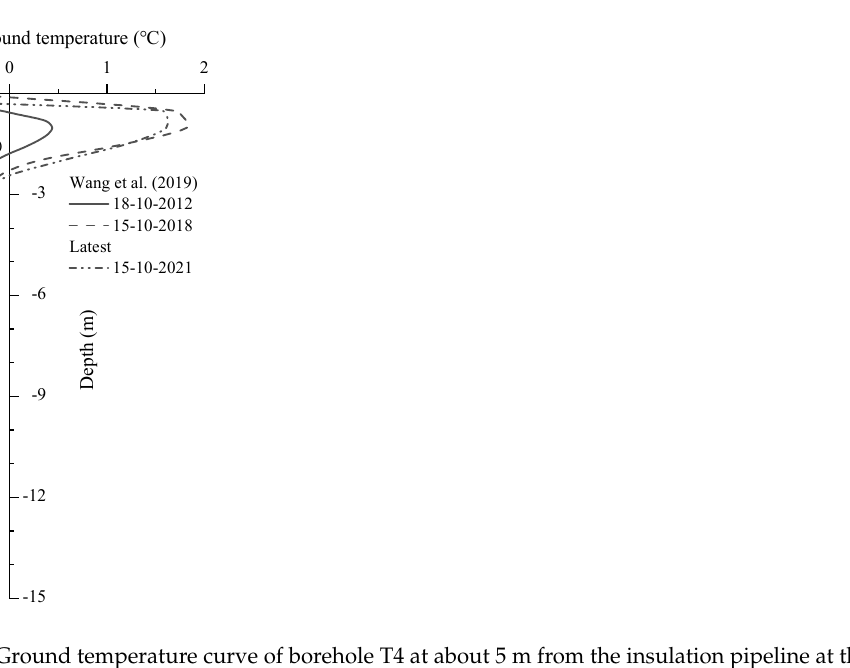
Figure 15. Ground temperature curve of borehole T4 at about 5 m from the insulation pipeline at the MDS304 site, compared with data from Wang et al. (2019)